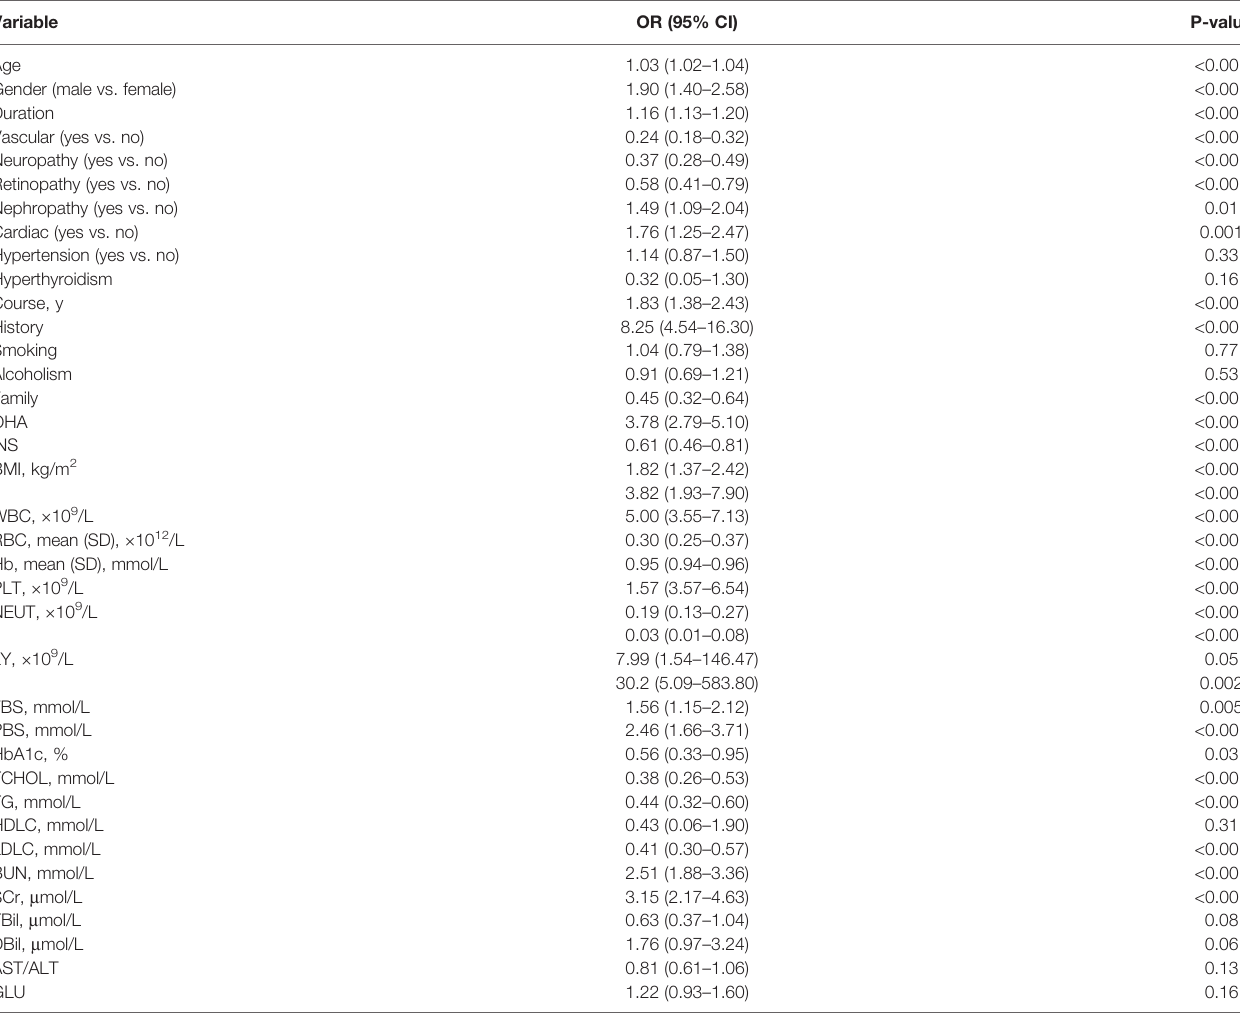
TABLE 2 | Univariate logistic regression analysis of DFU based on preoperative data in the training cohort.